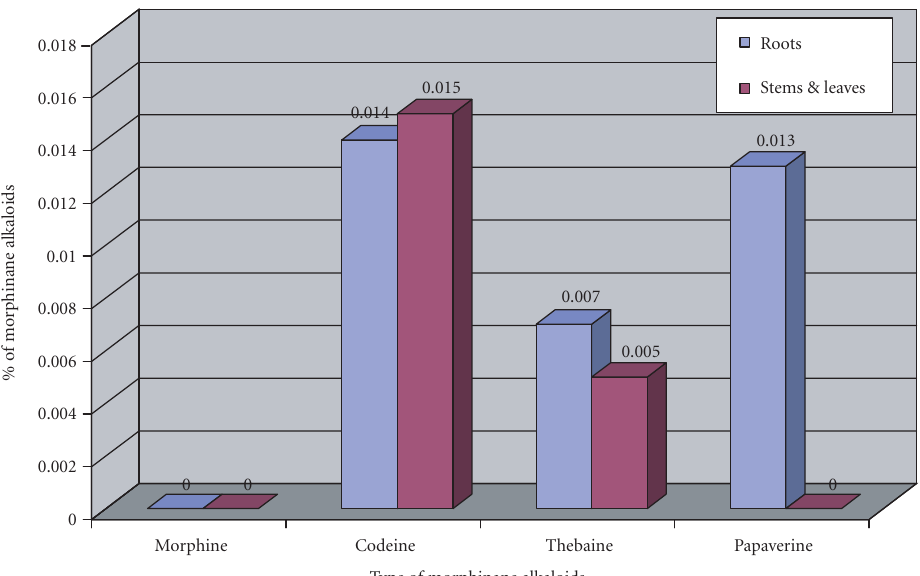
Figure 7:Concentrationsof morphinanealkaloids(mg/100mgof dryedmaterial)obtainedinfunctionof explantstested,in Papaverorientale splendidissimum .